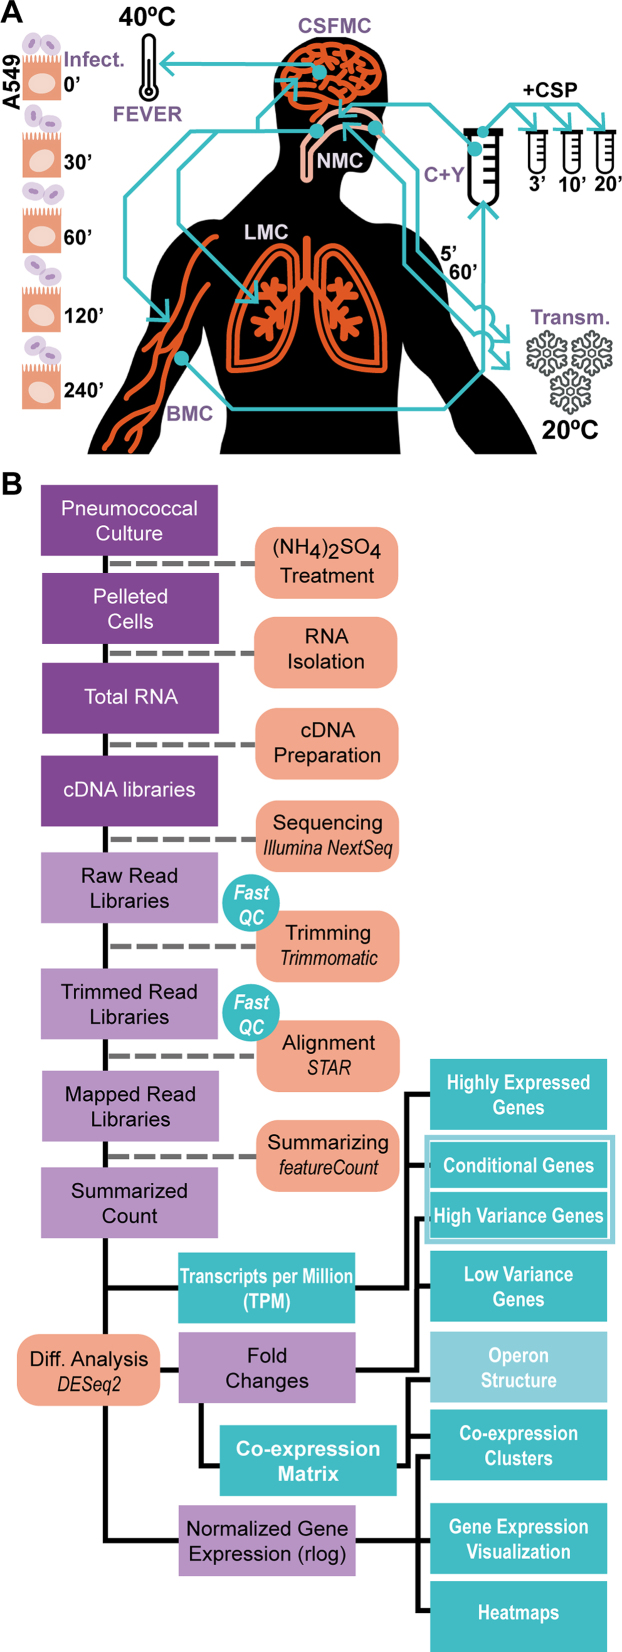
Mimicking conditions relevant to the opportunistic pathogen lifestyle. (A) Twenty-two conditions were selected, including growth in five different conditions (laboratory, in C+Y medium [C+Y], NMC, LMC, BMC and CSFMC); a model of meningeal fever (FEVER); transmission conditions; eight transfers between conditions; three competence time-points and five epithelial co-incubation time-points (Table 1). (B) cDNA libraries were prepared without rRNA depletion. Quality controls of the reads were performed before and after trimming. Trimmed reads were aligned and counted. Next, highly and conditionally expressed genes were categorized based on normalized read counts, while high- and low-variance genes were classified based on fold changes. High-variance and conditionally expressed genes together were defined as dynamic genes.